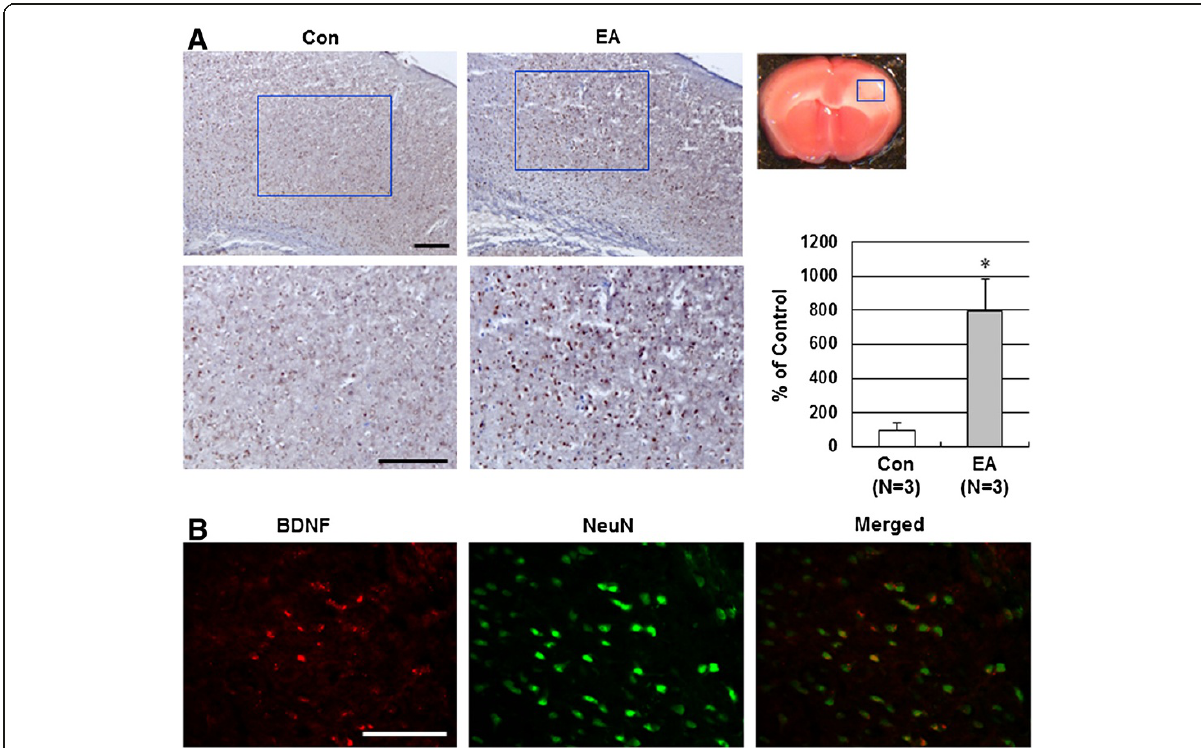
Figure 4 Effect of EA preconditioning on BDNF expression in ischemic brain. (A) Representative immunohistochemical staining photographs showed BDNF-positive cell expression 24 h after occlusion in the ischemic cortex of mice that received control or EA. The blue rectangle represents the imaging field. Quantification of BDNF-positive cells is expressed as the % change of the control. The results are expressed as mean ± SEM for three mice in each group. * , P <0.05 vs. control (Con). (B) Representative double immunofluorescence staining for BDNF (red) and NeuN (neuronal marker, green) in EA-preconditioned ischemic brain. EA-induced BDNF expression was colocalized with the neurons after ischemic injury. Scale bar = 100 μ